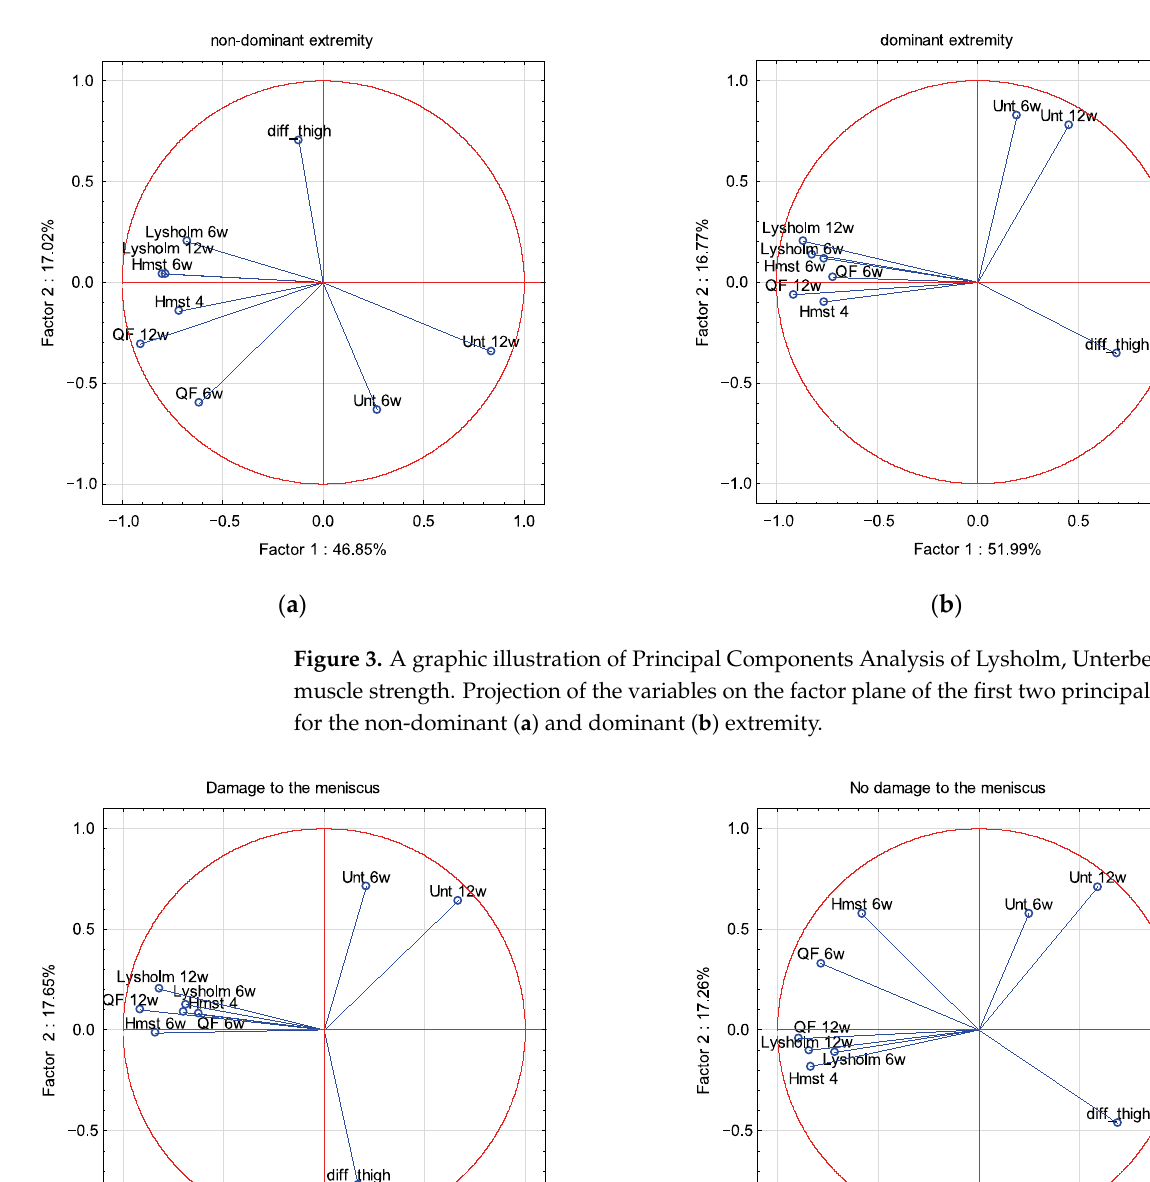
Figure 2. A graphic illustration of Principal Components Analysis of Lysholm, Unterberger test and muscle strength. Projection of the variables on the factor plane of the first two principal components for the men ( a ) and women ( b ).